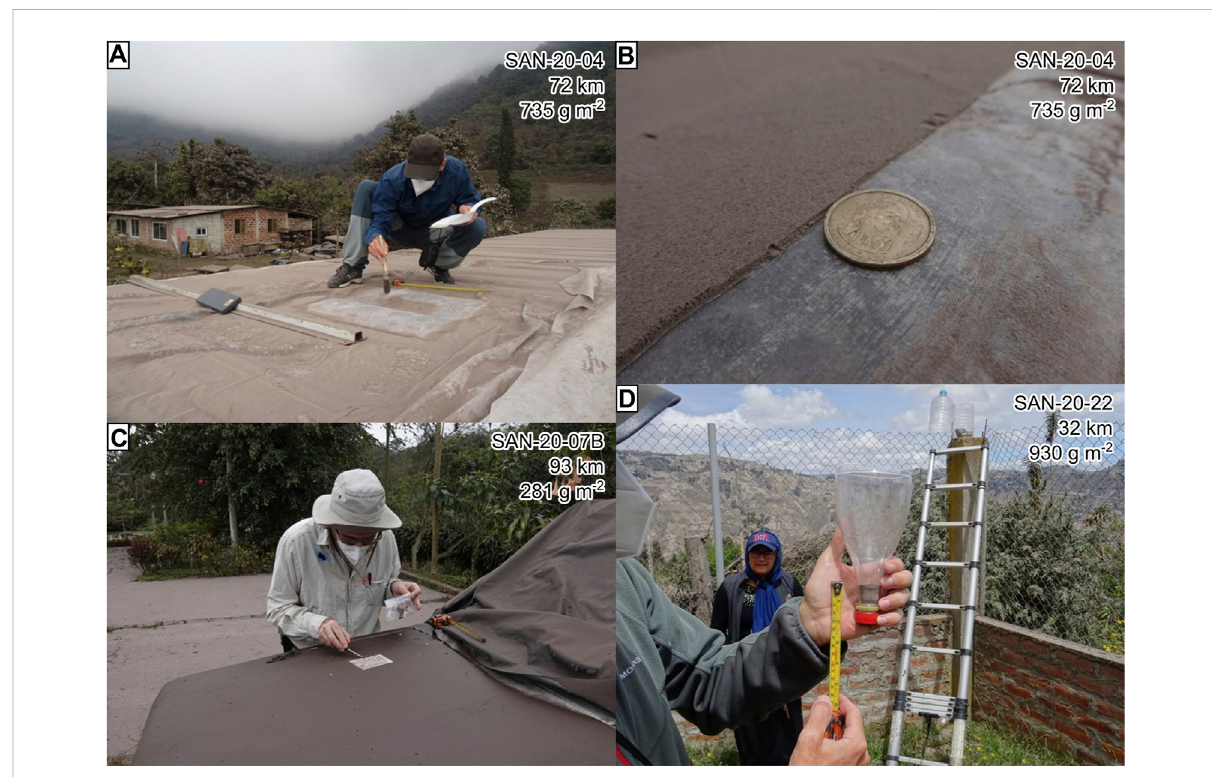
FIGURE 2 Ash sampling and fi eld measurements of the September 20, 2020 ash fallout from Sangay volcano. (A) Sillagoto (SAN-20 – 04), September 20, 2020; (B) Sillagoto, dollar coin (2 mm-thick) for scale; (C) Cumandá (SAN-20-07B), September 21, 2020, wet deposit; (D) San Nicolás ashmeter (SAN-20 – 22), September 22, 2020. Color changes in D are due to moisture and thickness of the plastic of the inner container. Distance from the volcano in km and load in g m − 2